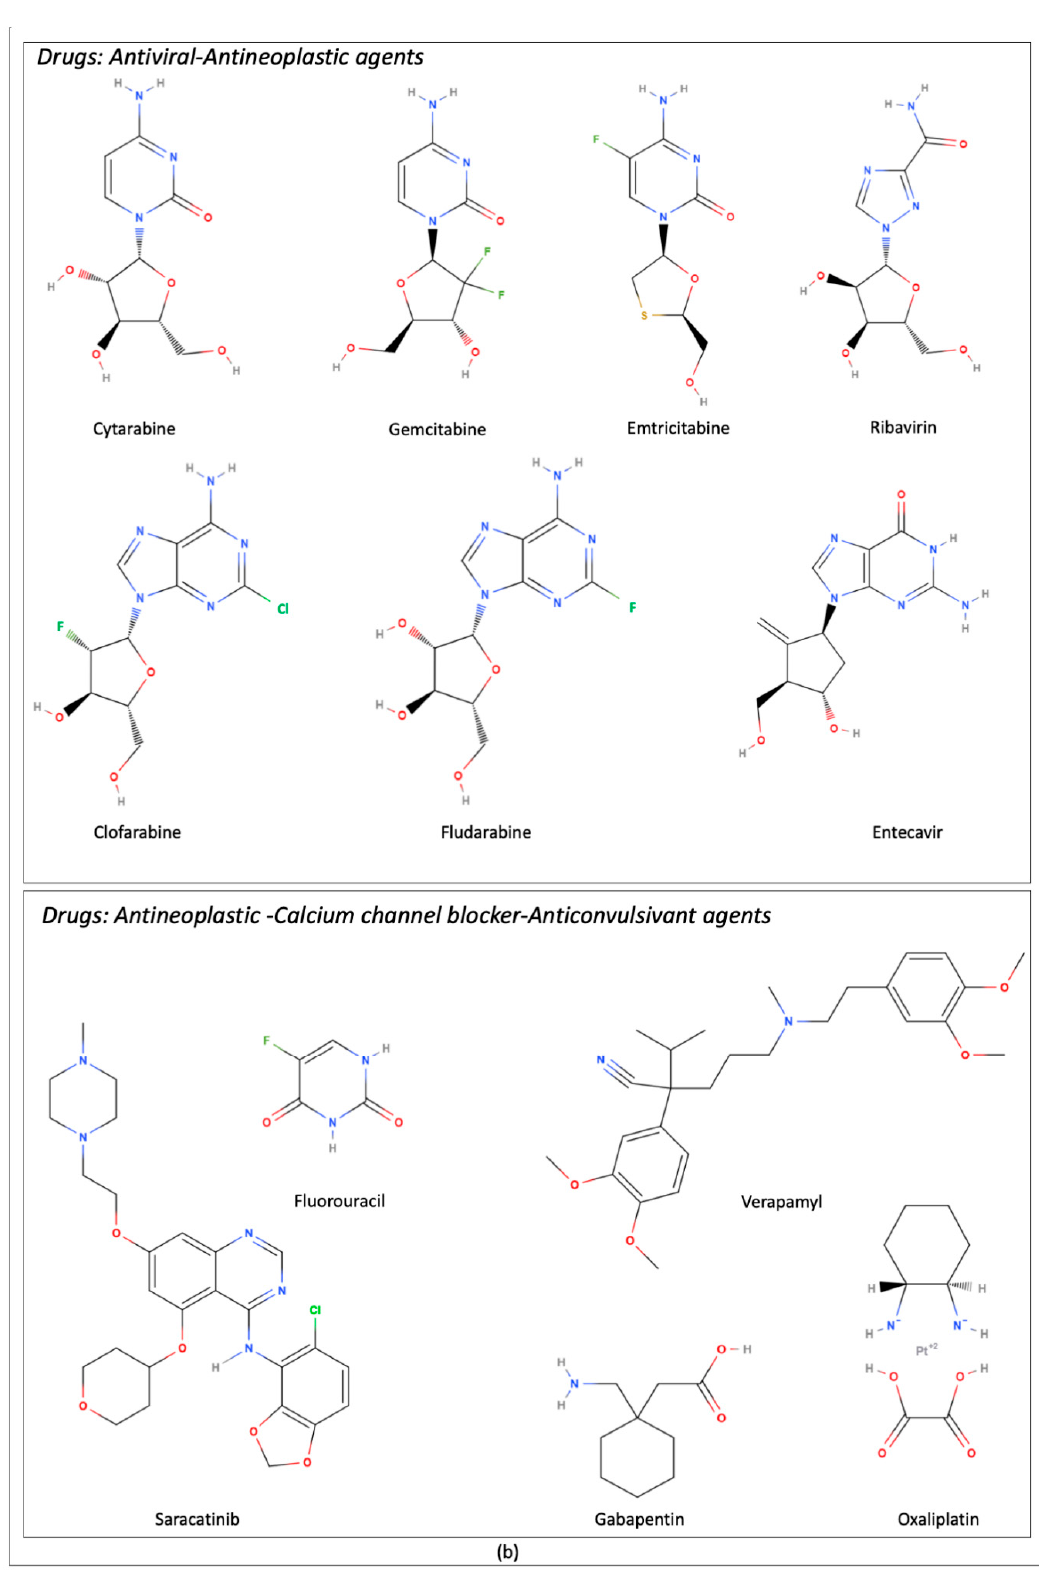
Figure 1. Image of the structural formula of molecules for which transport mediated by the Novel Organic Cation Transporter 1, OCTN1 has been demonstrated. Nitrogen atoms are colored in blue, Oxygen atoms in red, Hydrogen atoms in gray, Halogen atoms in green. ( a ) Human and Exogenous metabolites. ( b ) Drugs, organized in different panels on the basis of structure